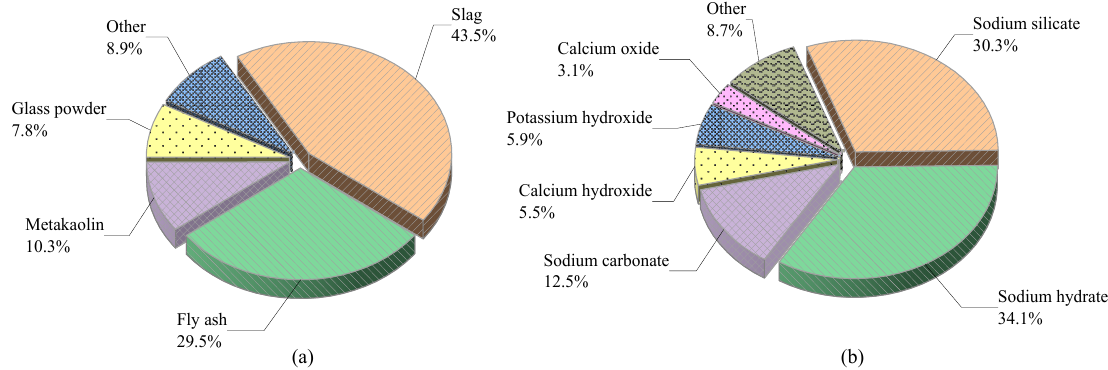
Figure 5. Statistics on the use of AAM ( a ) precursors and ( b ) activators.